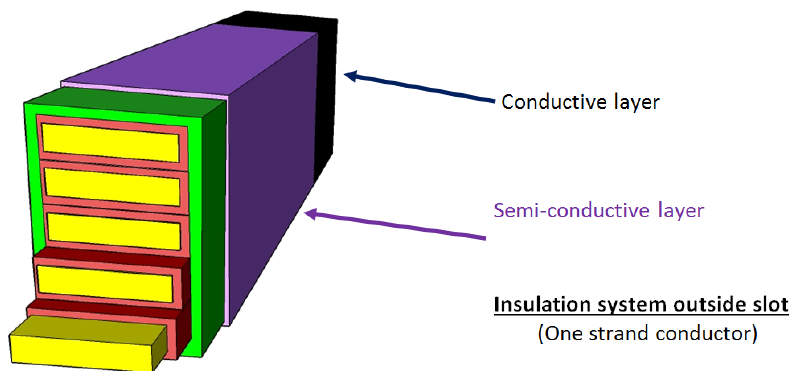
Figure 3. The conductive layer is grounded (ground potential); the difference of potential between the conductive layer and the main insulation depends on the voltage supply. It creates at the end of the conductive layer one area with excessive electrical stress. Such electrical stresses can be mitigated by the use of a semi-conductive layer.